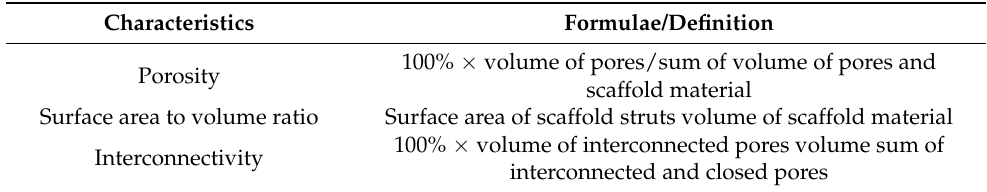
Table 2. Morphological properties of 3D printed scaffolds and formulae used for the evaluation of porosity, surface area to volume ratio, and interconnectivity [6]. Characteristics Formulae/Definition 100% × volume of pores/sum of volume of pores and Porosity scaffold material Surface area to volume ratio Surface area of scaffold struts volume of scaffold material 100% × volume of interconnected pores volume sum of Interconnectivity interconnected and closed